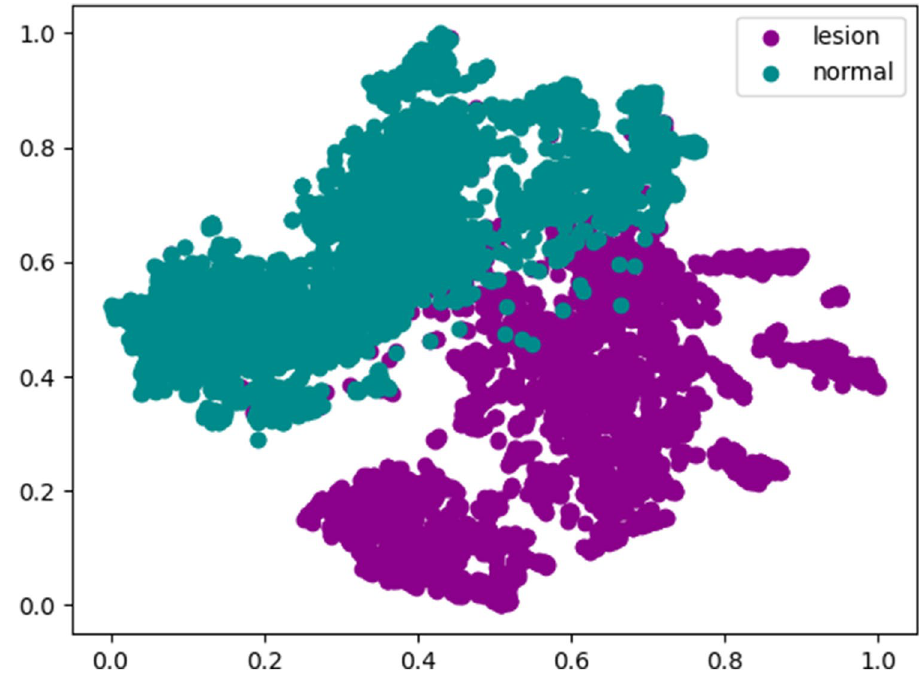
Figure 5. t-SNE plot demonstrating cluster assignment of the CNN model.